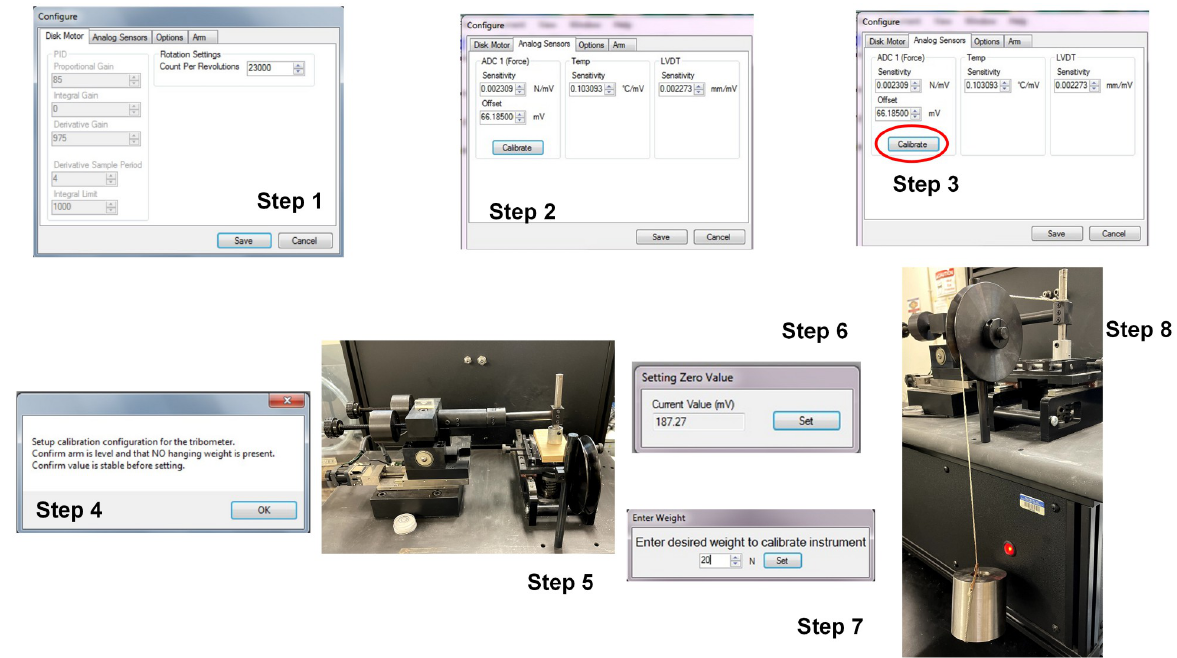
Fig 3. Step by step procedure for calibration of the load sensor in Nanovea